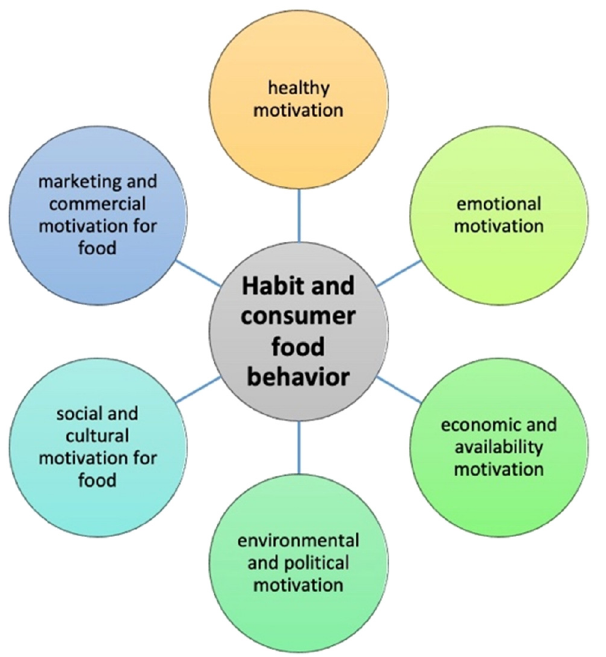
Figure 3: Impact of motivation food factors and consumer behavior